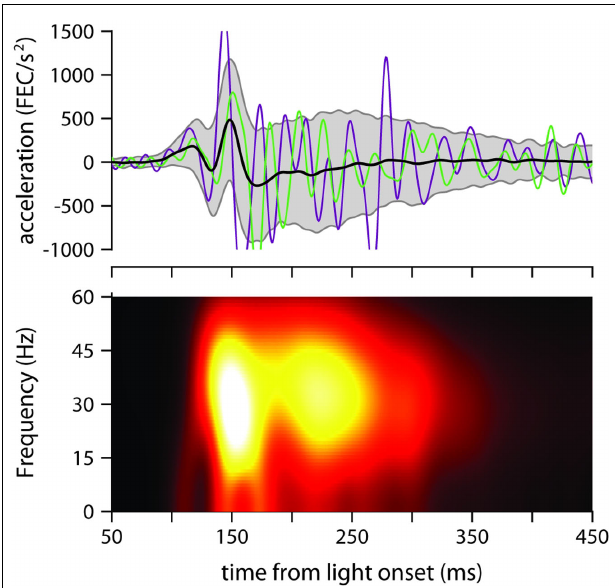
FIGURE 4 | Eyelid acceleration. Top : mean eyelid acceleration (black) ± 1 SD (gray shaded region), and example acceleration records from two randomly selected trials (green and purple), for one of the mice trained with a 175-ms ISI (same mouse as in Figure 3A ). Bottom : mean of all single-trial spectrograms of the eyelid acceleration signal for the same mouse (see Materials and Methods for details about spectrogram generation).